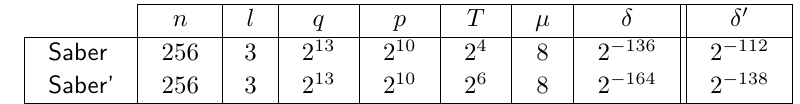
Table 10: Parameter sets for Saber, with the original failure probability δ , and the failure probability δ 0 for ∆ = 0 .